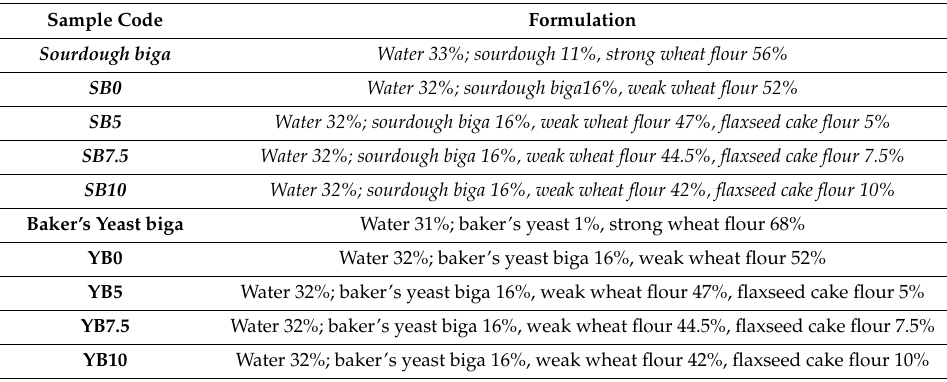
Table 1. Sample codes and di ff erent formulations of bread objects of the research. Data reported in italics were already published in Sanmartin et al., 2020 [39]. SB: sourdough, YB: baker’s yeast. Sample